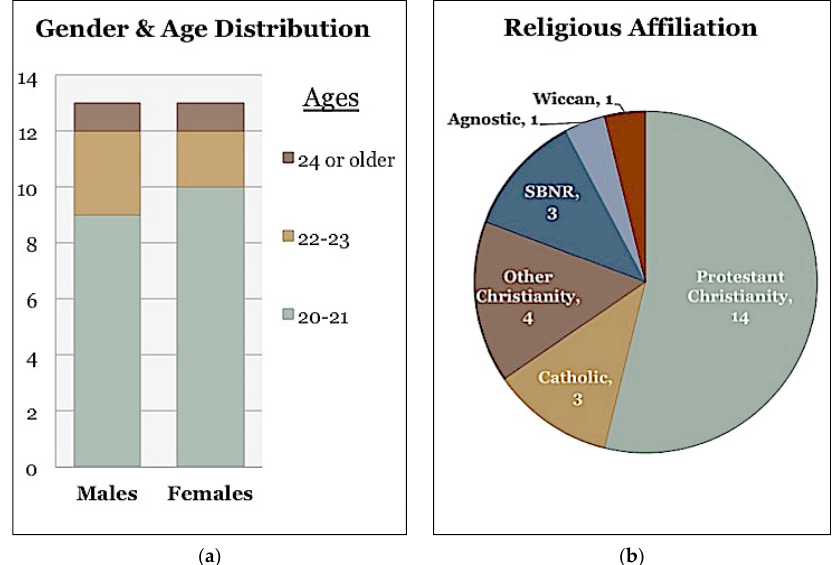
Figure 2. Primary class gender, age, and major at Time 1. ( a ) The primary class represented a slightly greater proportion of female students compared to the control group students. Within the class there was even representation among genders, with female students being slight younger than the male students (y ‐ axis is student counts); ( b ) more than two ‐ thirds of students were Protestant or Catholic. students (y-axis is student counts); ( b ) more than two-thirds of students were Protestant or